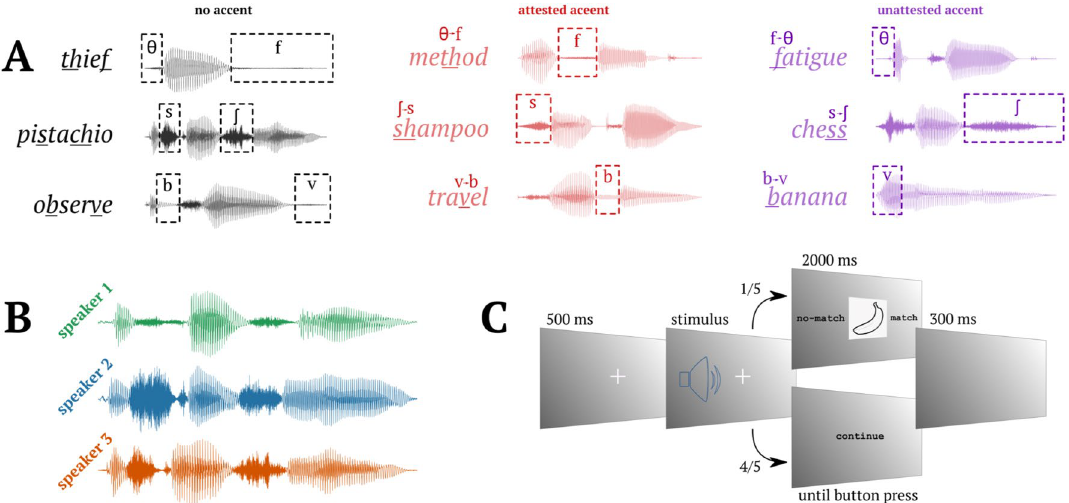
Figure 1. Experimental stimuli and design. ( A ) Experimental conditions. In black, left column: baseline condition. In red, middle column: attested substitutions. In purple, right column: unattested substitutions. ( B ) Waveform of three speakers’ pronunciation of pistachio . ( C ) Trial